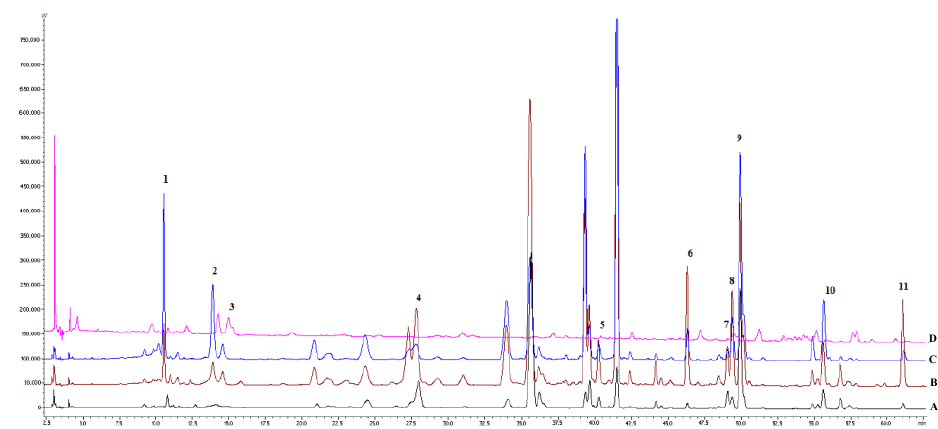
Figure 2. The HPLC-DAD chromatograms of the methanolic extracts of I. pallida ( A ), I. hungarica ( B ), I. variegata ( C ), I. sibirica ( D ): Gallic acid ( 1 ), mangiferin ( 2 ), caffeic acid ( 3 ), tectoridin ( 4 ), germanism B ( 5 ), irisolidone- D -glucoside ( 6 ); iristectorigenin B ( 7 ), nigricin ( 8 ), irigenin ( 9 ), 5,6-dihydroxy-7,8,3′,5′-tetramethoxyisoflavone ( 10 ), and irisolidone ( 11 ).